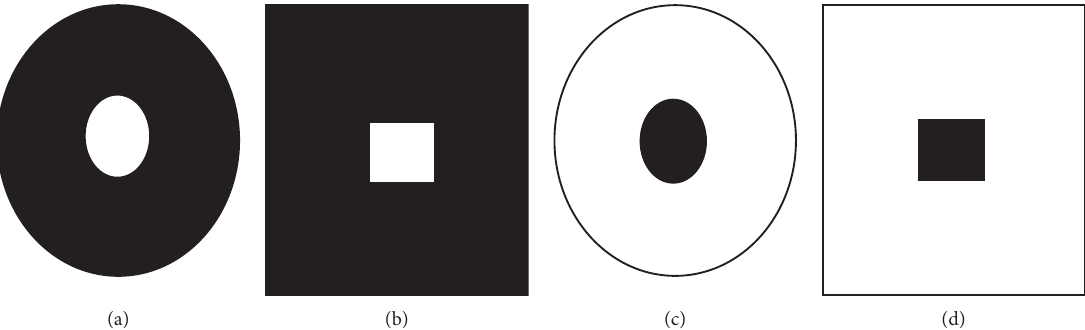
Figure 4: On-centre and off-centre ganglion cells and visual saliency map approaches: (a) on-centre ganglion cell, (b) on-centre re- semblance, (c) off-centre ganglion cell, and (d) off-centre resemblance [15].